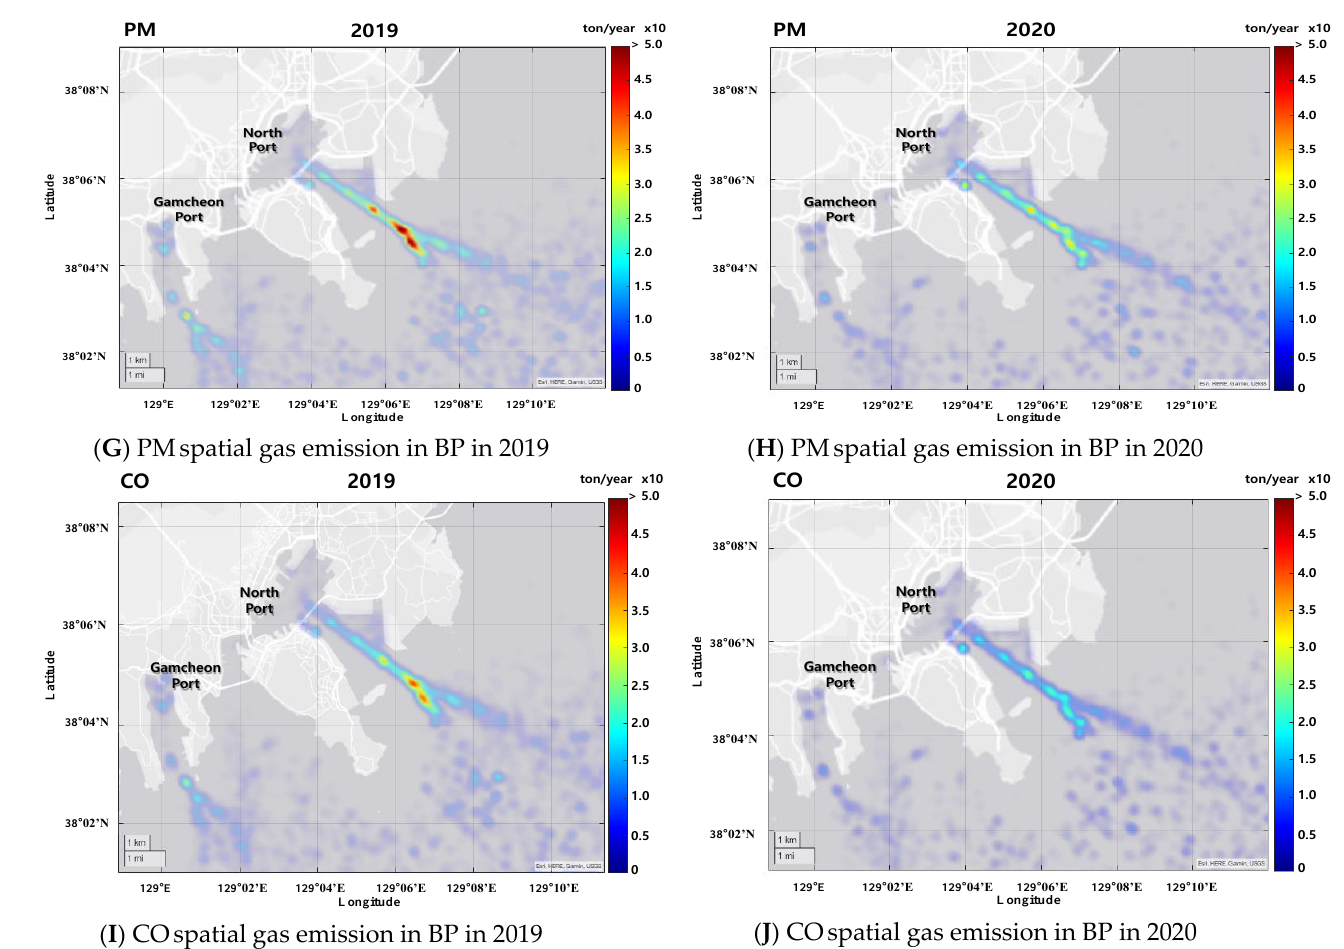
Figure 8. Comparison of the spatial analysis of the five air pollutants in BP in 2019 and 2020.